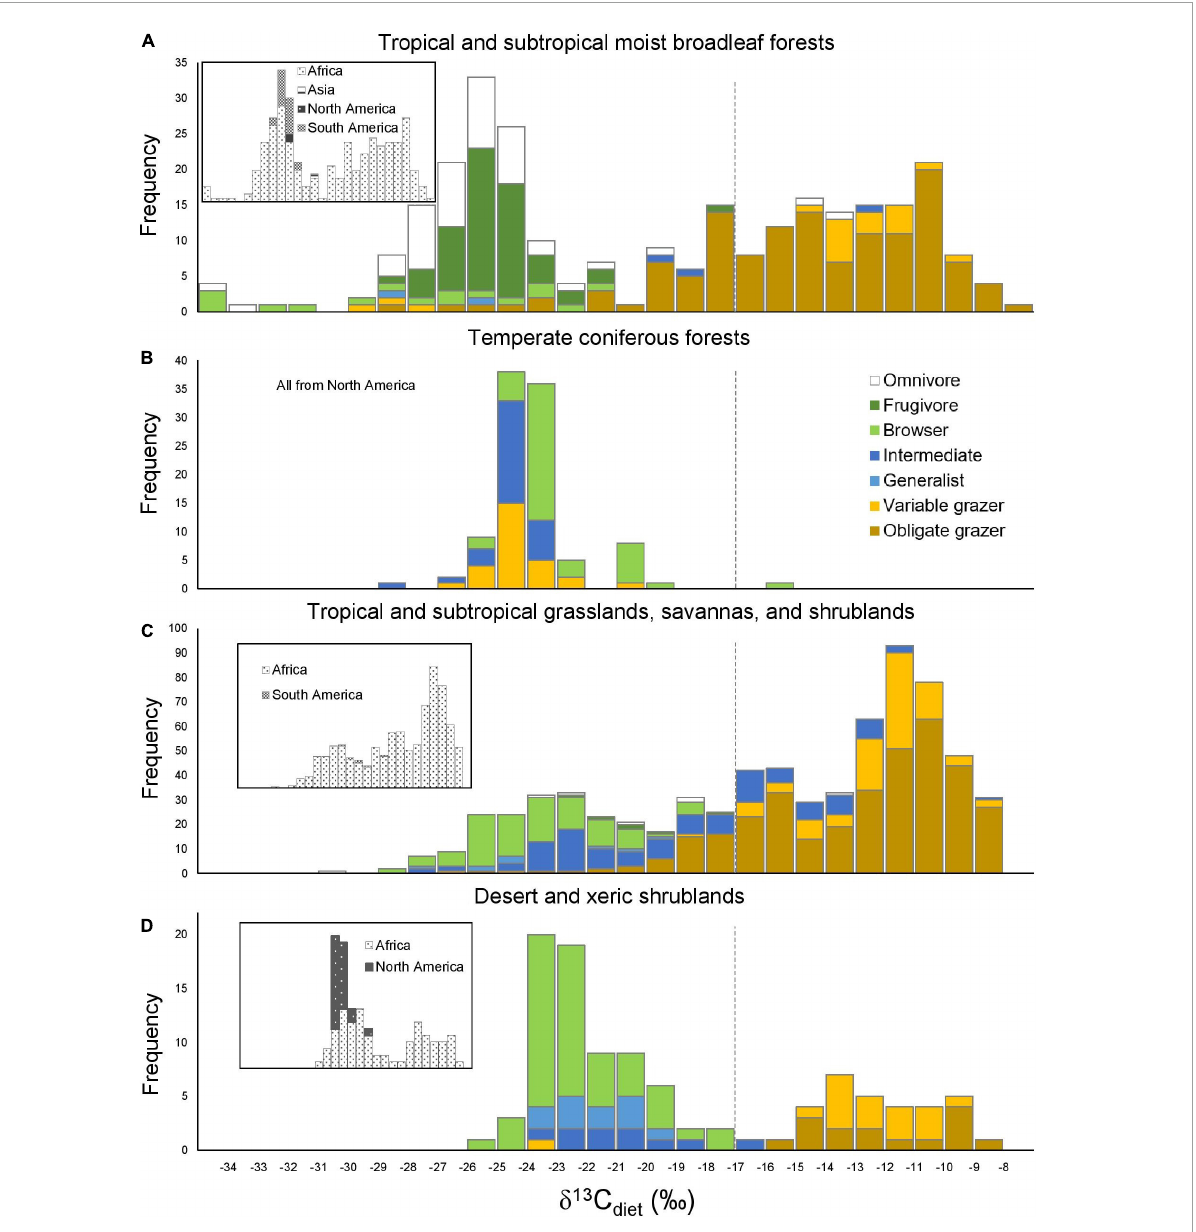
FIGURE5 Histograms of δ 13 C diet values in the four best-sampled ecoregions in relation to feeding categories (A,B) (main panels) and continent (C,D) (inset panels). Dashed line is the C 3 -C 4 boundary.